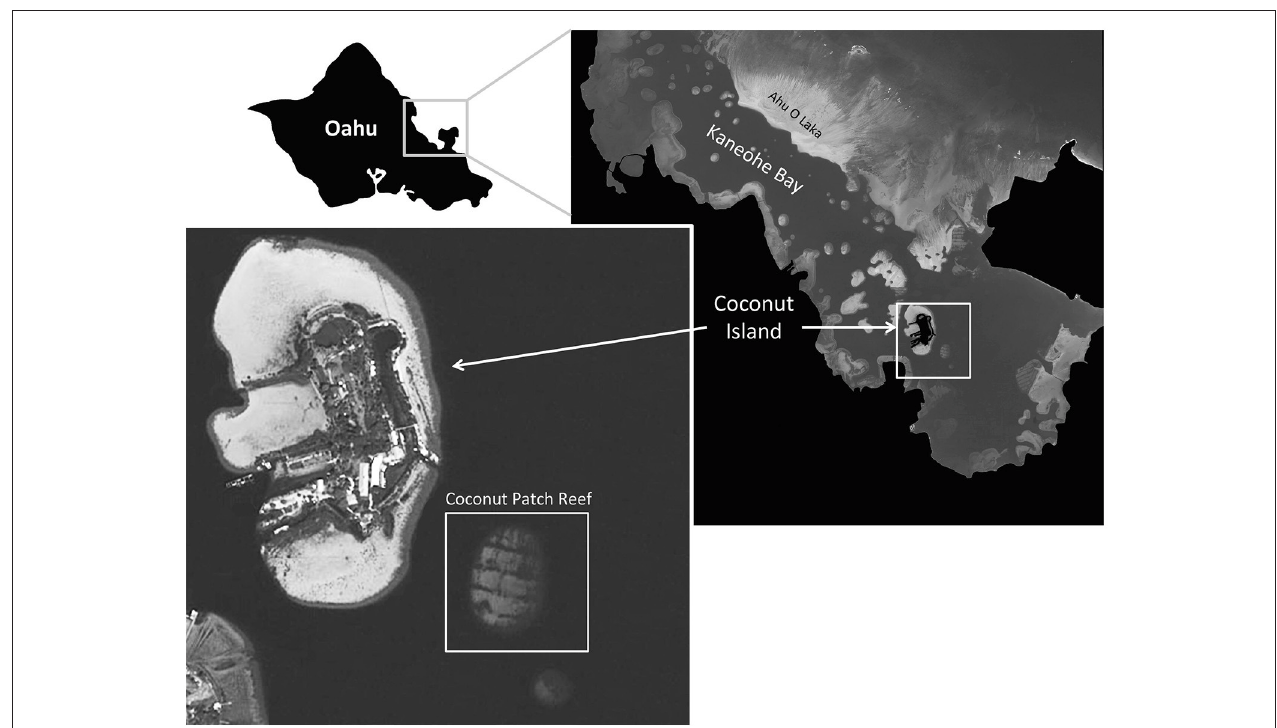
FIGURE 1 | The study location, Kane’ohe Bay, is located on the east coast (windward side) of O’ahu, Hawai’i. In situ physical and optical measurements were collected across a shallow patch reef located off the southeast shore of Coconut Island in the southern portion of the